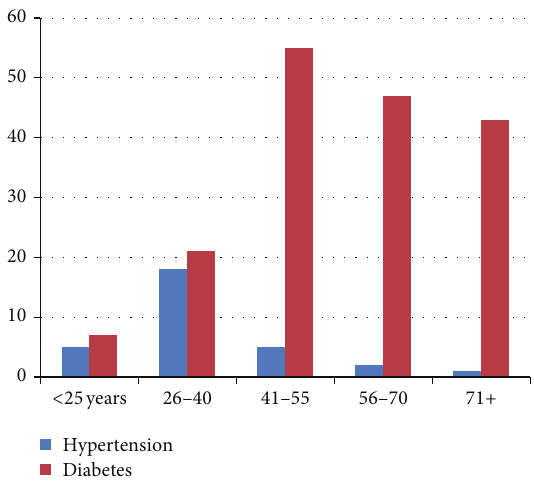
Figure 4: Description of the normal wt by hypertension and diabetes and by different age